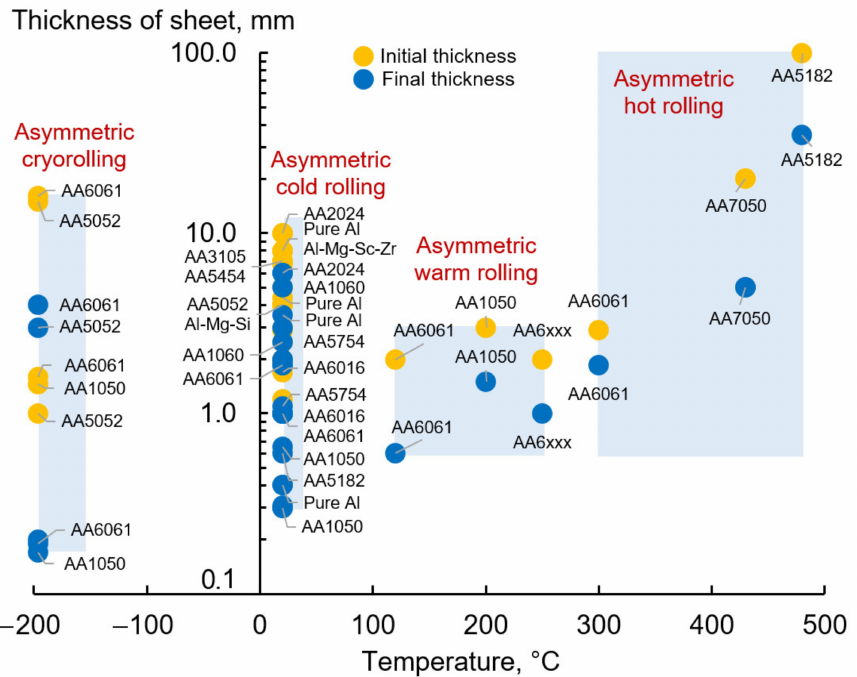
Figure 37. Different Al alloys, which were processed by asymmetric (hot, warm, cold) rolling (based on data from Tables